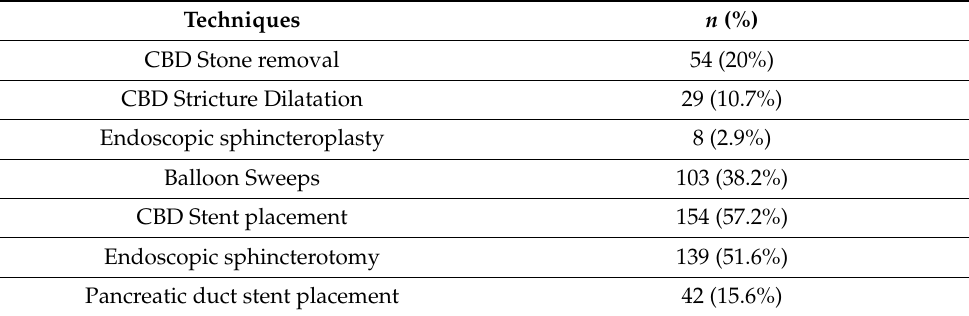
Table 2. Techniques used in ERCP.